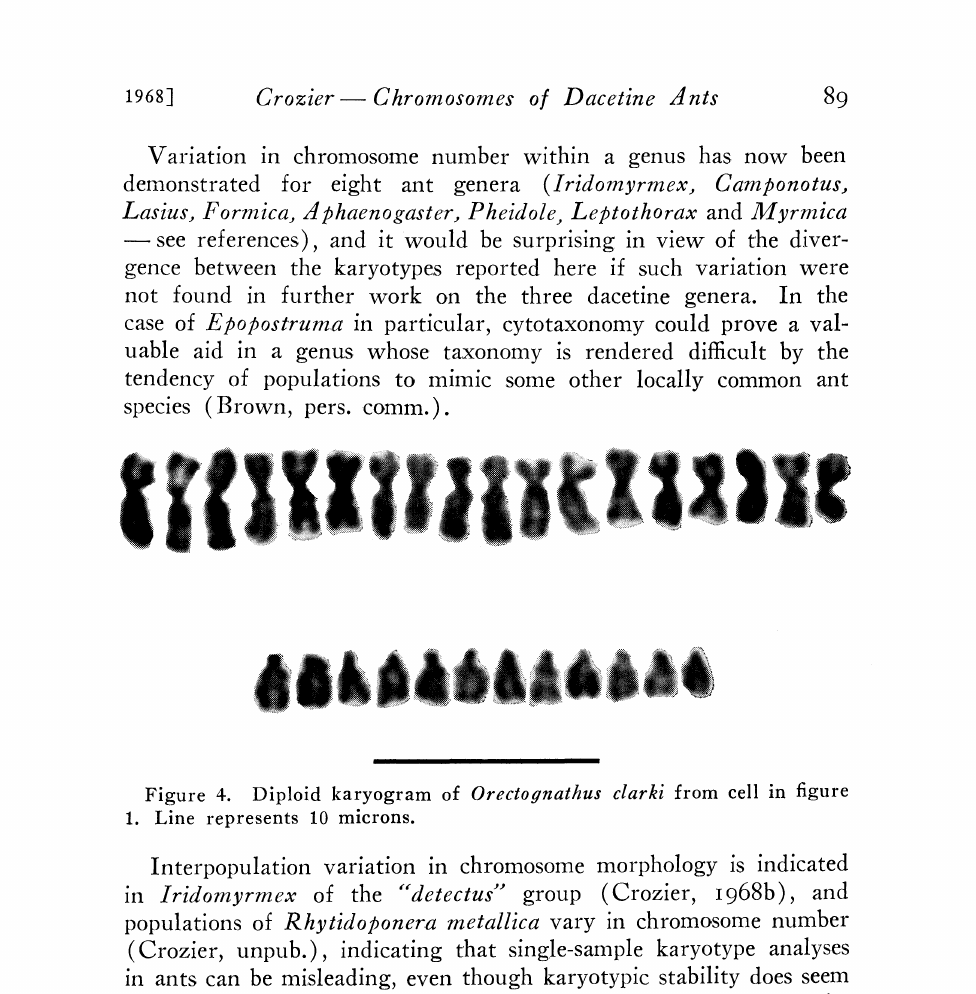
Figure 4. Diploid karyogram of Orectotnathus clarki from cell in figure 1. Line represents 10